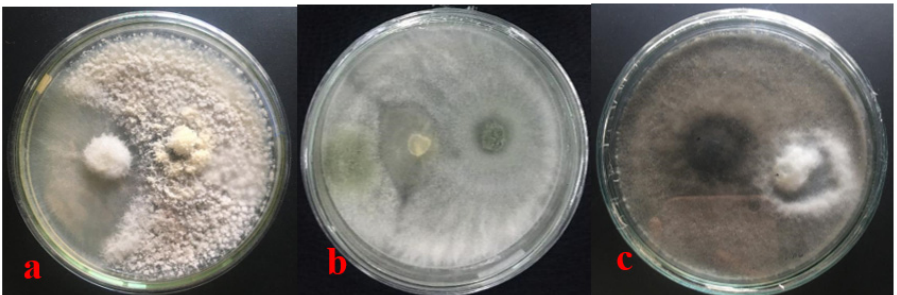
Figure 5. Inhibition (%) 7th day ( a ) Nigrospora sphaerica ( b ) Trichoderma harzianum ( c ) Lasiodiplodia theobromae.